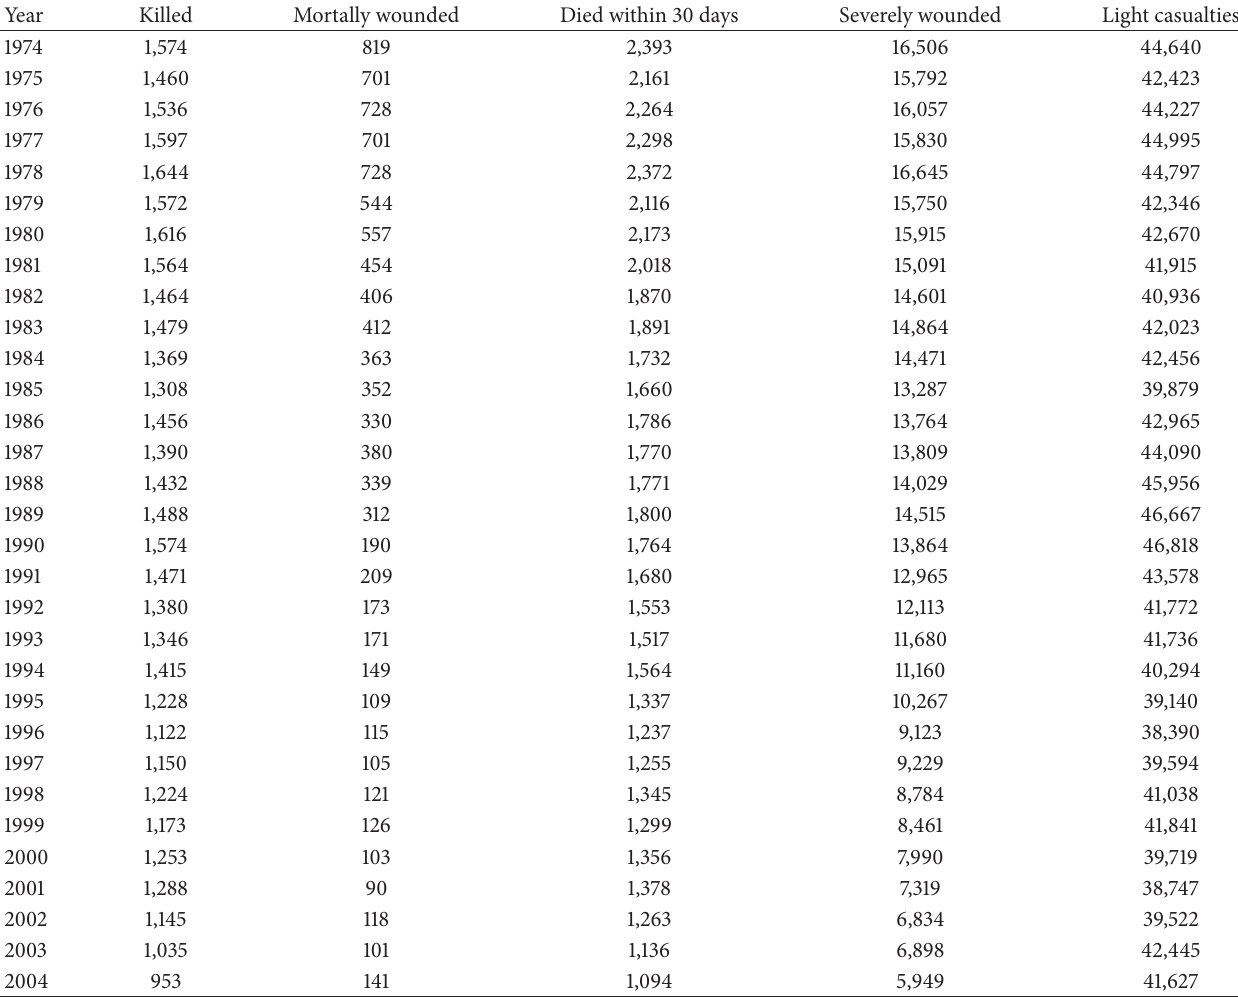
Table 1: Yearly car accident causalities in Belgium from 1974 to